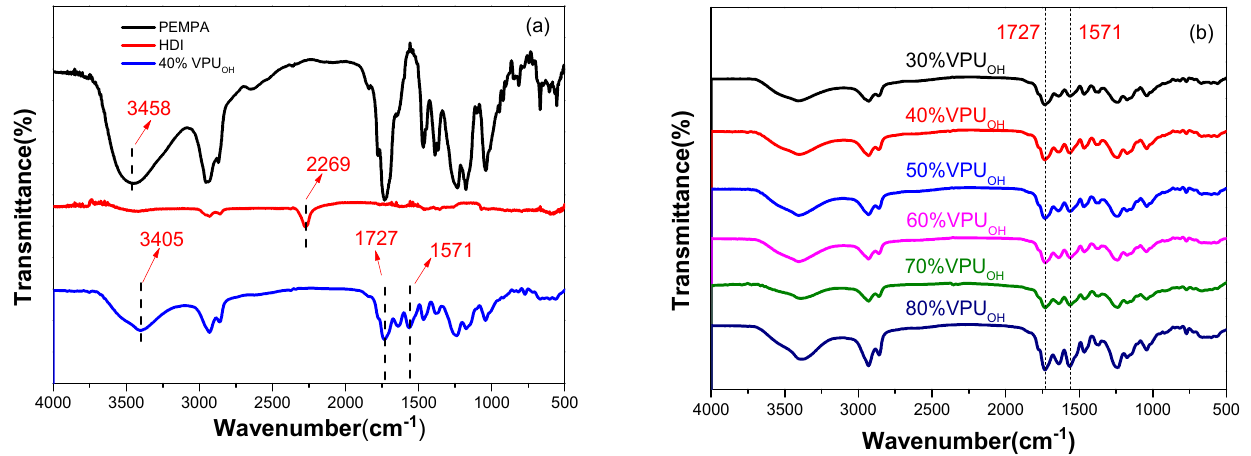
Figure 2. FTIR spectra: ( a ) HDI, PEMPA, and 40%VPU OH , ( b ) VPU OH with different HDI content.